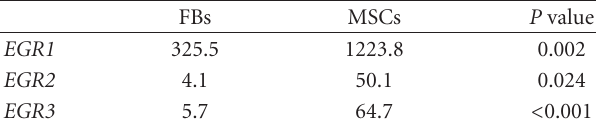
Table 1: EGR1-3 gene expression in human primary fibroblasts (FBs) and human primary mesenchymal stem cells (MSCs) from GEO database (GSE9451). EGR1 data was published previously [25]. Gene expression was given in arbitrary